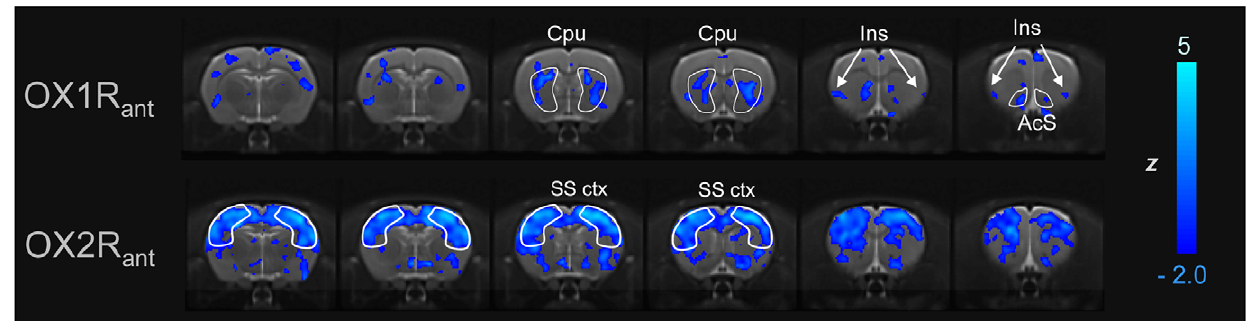
Figure 5. Attenuation of fMRI response by OX1R or OX2R antagonism. Regions of reduced amphetamine-induced rCBV response following pre-treatment with GSK1059865 (OX1R ant ; top) or JNJ10397049 (OX2R ant , bottom). Blue indicates reduced rCBV response versus control (vehicle- amphetamine). Cpu: caudate putamen; SS ctx: somatosensory cortex; Ins: insular cortex, AcS: shell of the nucleus accumbens.